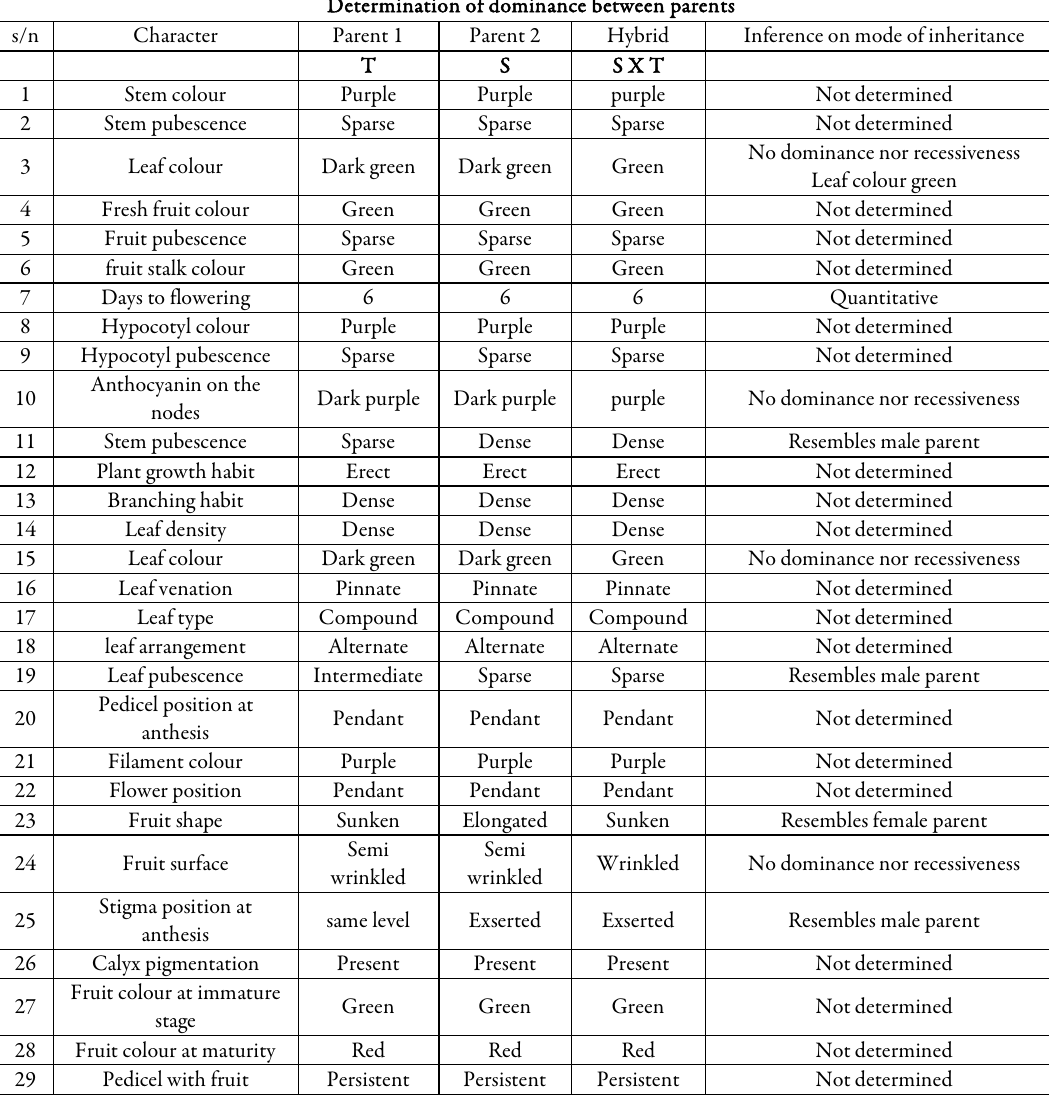
Table 10. Comparison of T and S Determination of dominance between parents